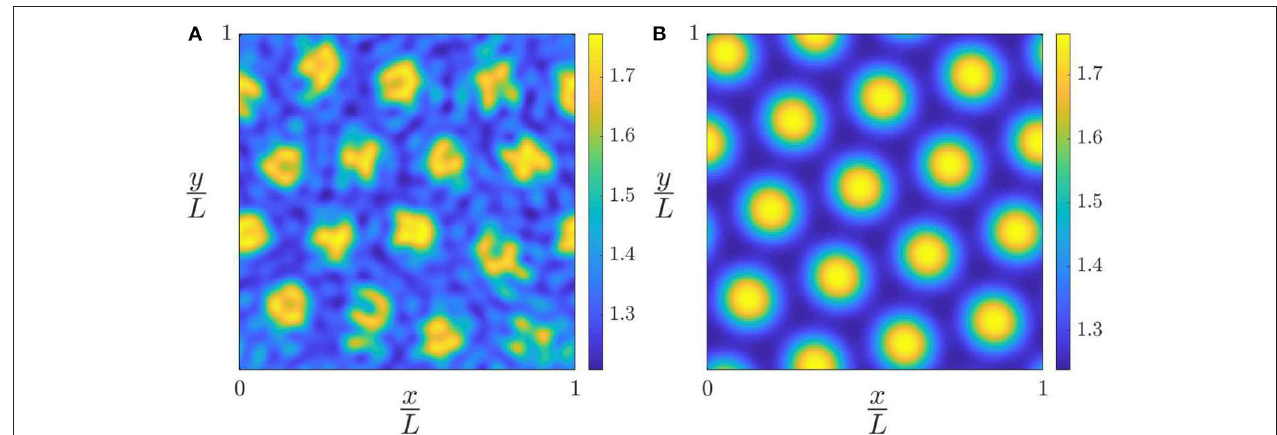
FIGURE 7 | (A) Contour plot of gap g ( x , y ) at a point in the unstable range for β corresponding plot for a smooth surface using the modified traction law.